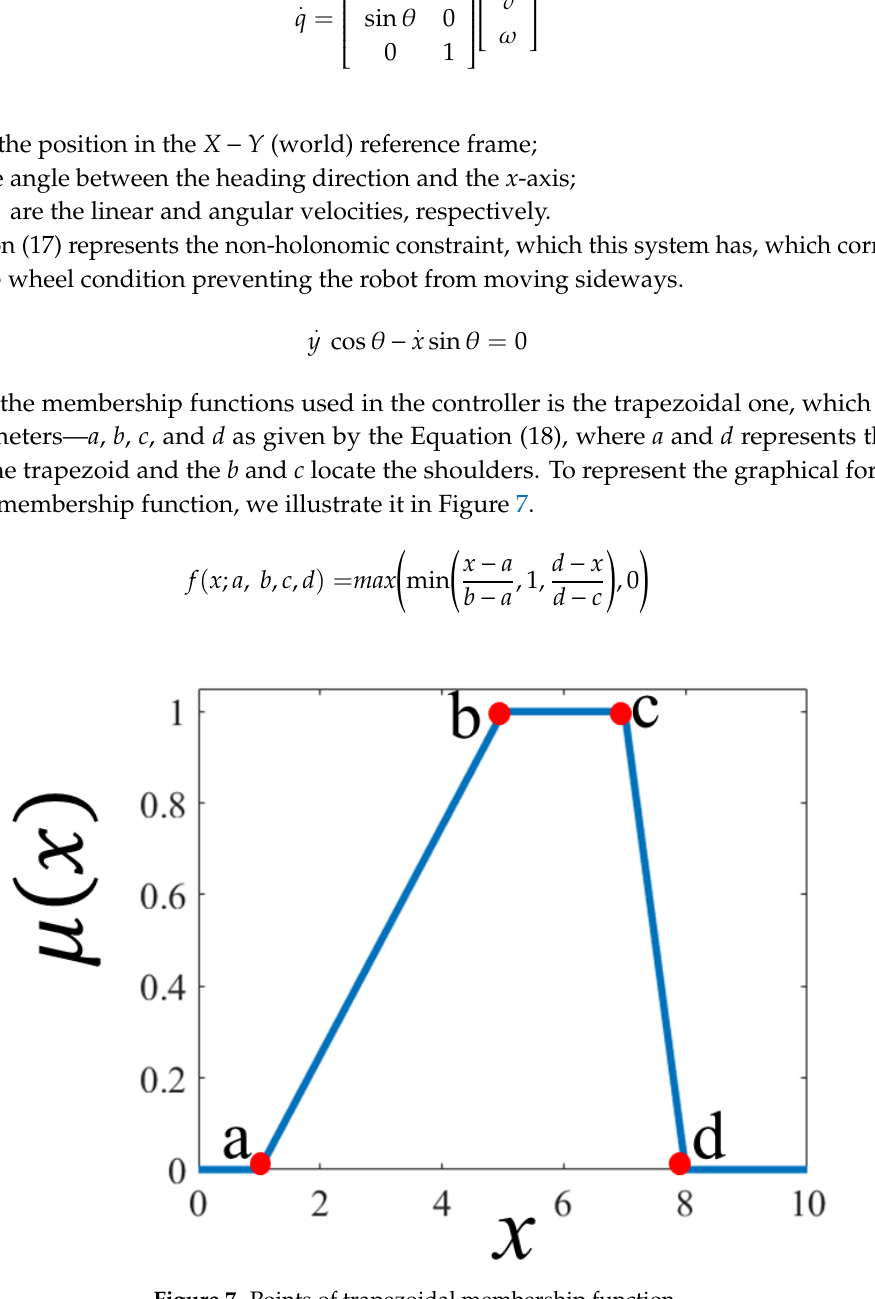
Figure 8. Points membership functions of Input 1 and Input 2. Tables 5 and 6 show the mathematical knowledge of each membership function for each of the inputs.